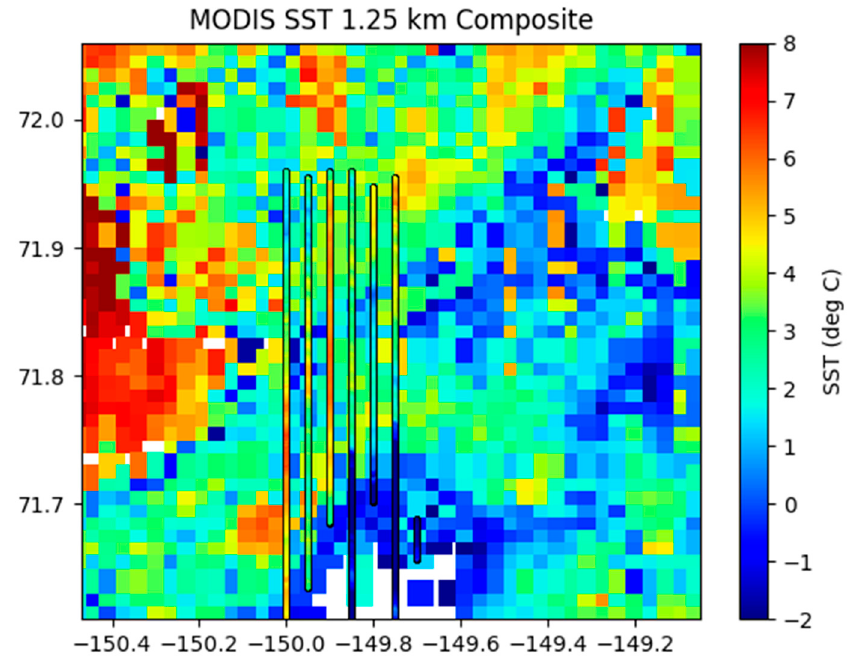
Figure 2. MODIS SST Maximum Value Composite with superimposed BESST back-shifted tracks, color-coded by the corresponding BESST SSTs. The western track was sampled first, with the aircraft heading northbound.